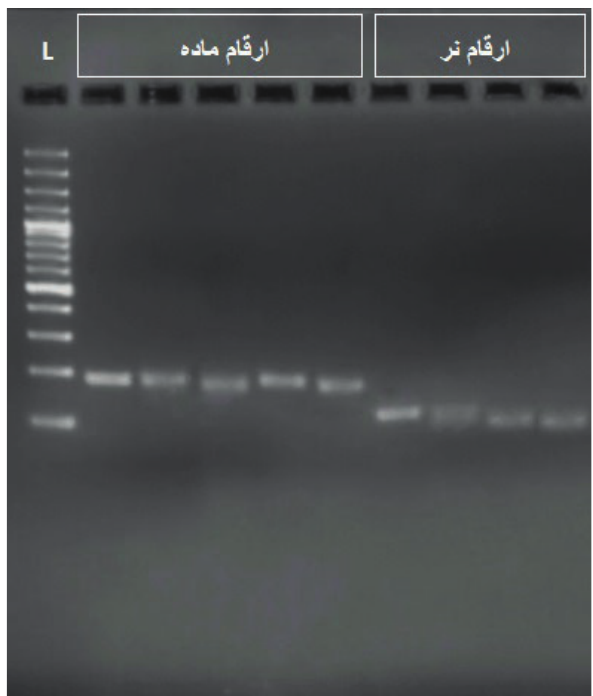
Figure S1. Allele pattern of some femal and male date palm trees. Left to right: first 5 samples are female and 6-9 male